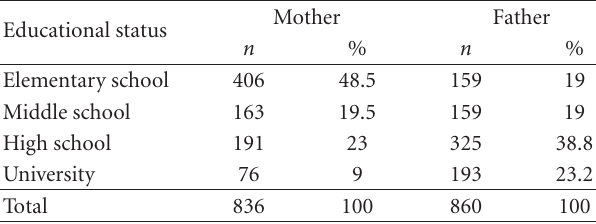
Table 2: Parental educational